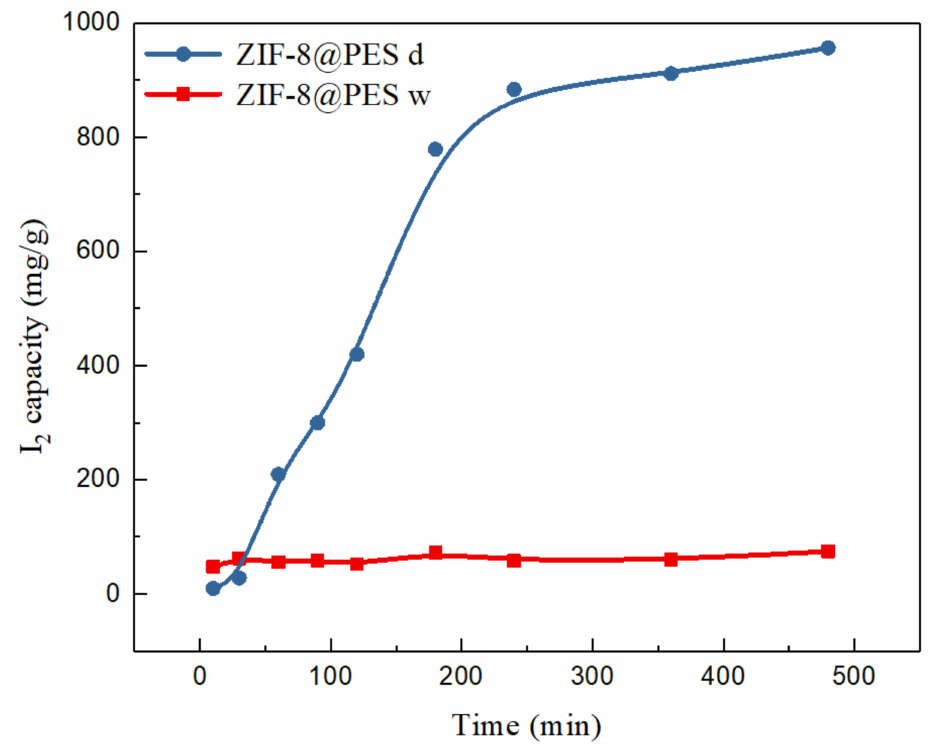
Figure 10. I 2 adsorption curve of the prepared MMMs (ZIF-8@PES d in blue and ZIF-8@PES w in